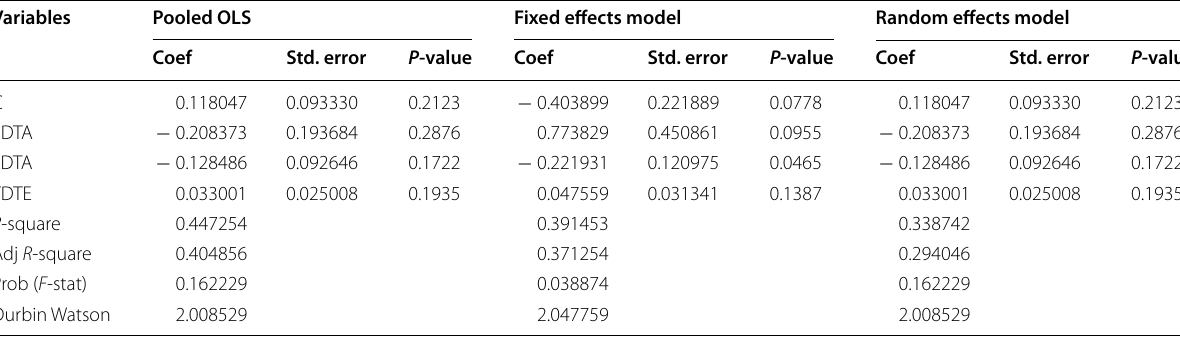
Table 3 Results of static panel data